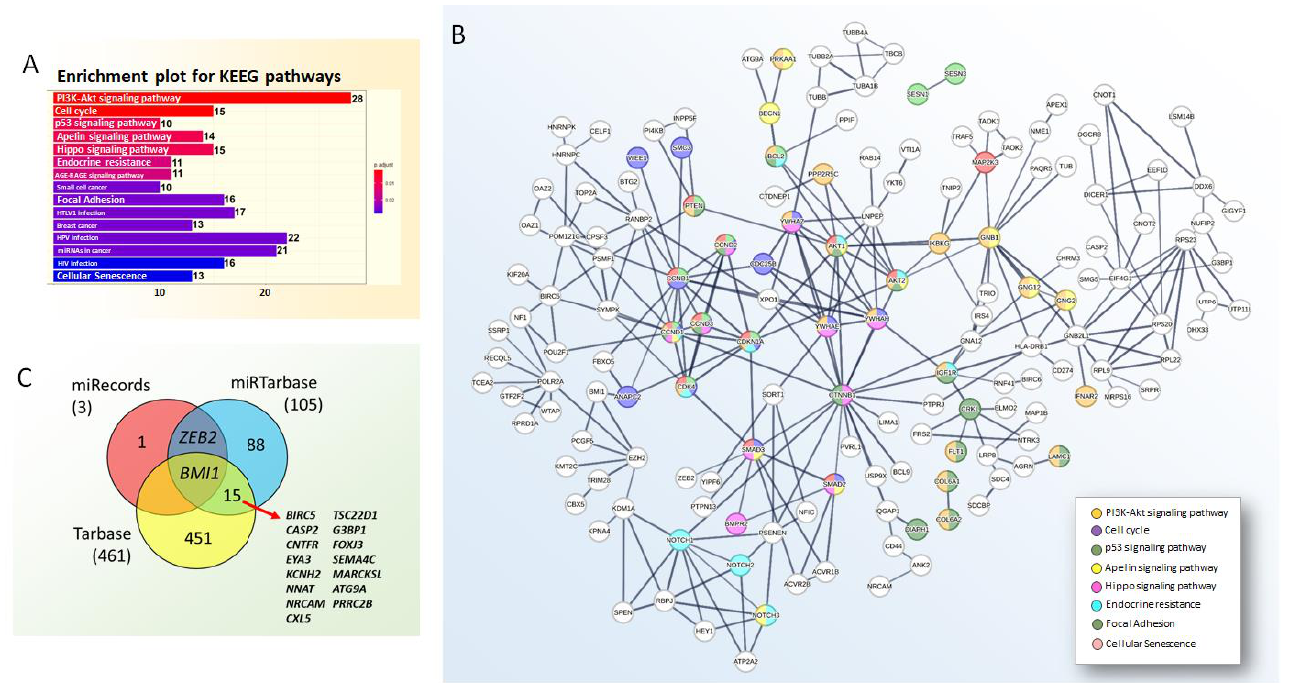
Figure 6. ( A ) Functional enrichment of miR-708-predicted targets through KEEG pathways. Note that most categories highlight key contributors to tumor phenotypes. ( B ) Protein–protein interactions were also accessed through the STRING v11.5 software (available at https://string-db.org/). The parameters evaluated were experiments and databases. The minimum required interaction score was 0.700, which was considered high confidence. The enrichment analysis was also performed using the same software. Network edges denote confidence and disconnected nodes were omitted. ( C ) Venn diagram representing hsa-miR-708-5p validated targets in miRecords, miRTarBase, and TaRbase database.